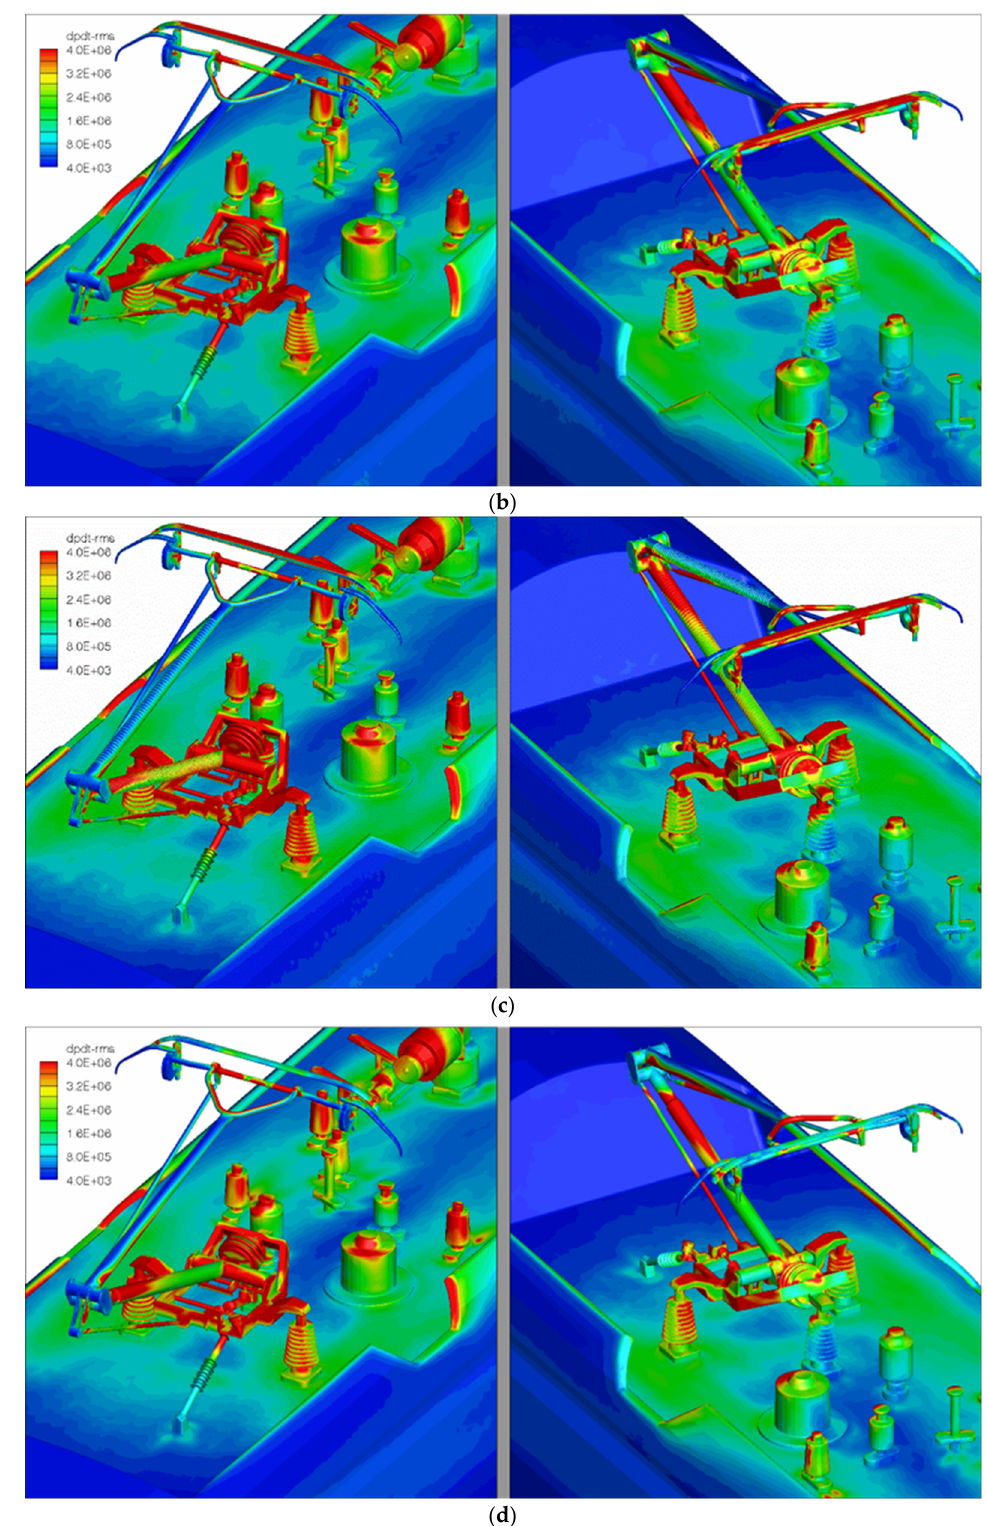
Figure 7. The d p d t − rms distribution cloud map around the pantograph. ( a ) Original model. Figure 7. The d d -rms p t distribution cloud map around the pantograph. ( a ) Original model. ( b ) Opened model. ( c ) Slotted model. ( d ) Airfoil model. ( b ) Opened model. ( c ) Slotted model. ( d ) Airfoil